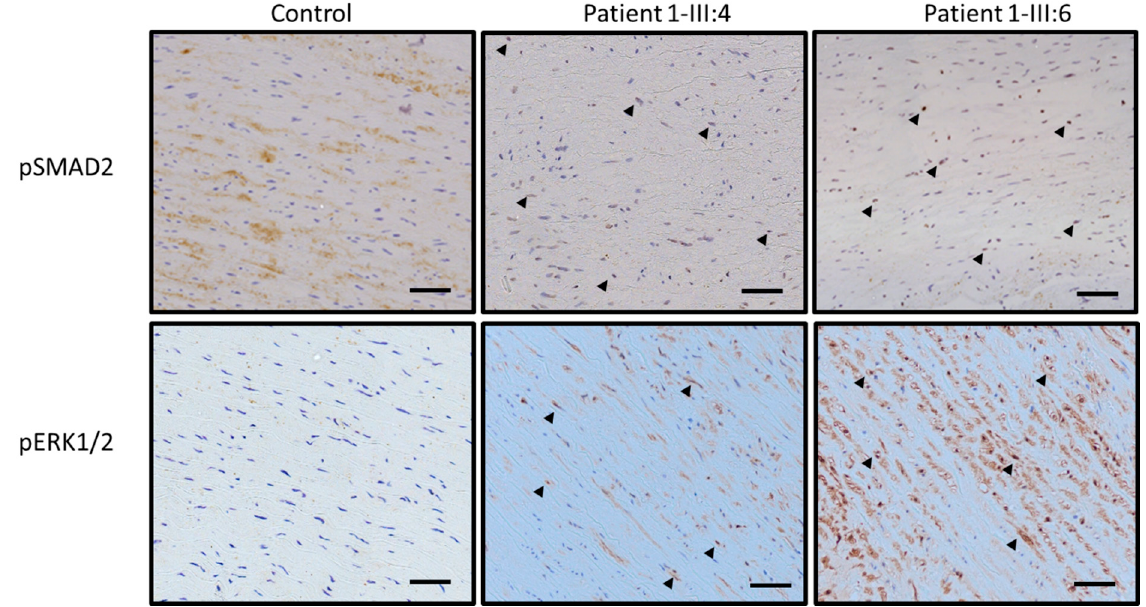
Figure 4. Pictures of immunohistochemistry stainings of pSMAD2 and pERK1/2 in a control and two LOX patients, re- spectively, 1-III:4 and 1-III:6. Black arrows indicate examples of positive stained nuclei. The scale bar represents 50 μ m.